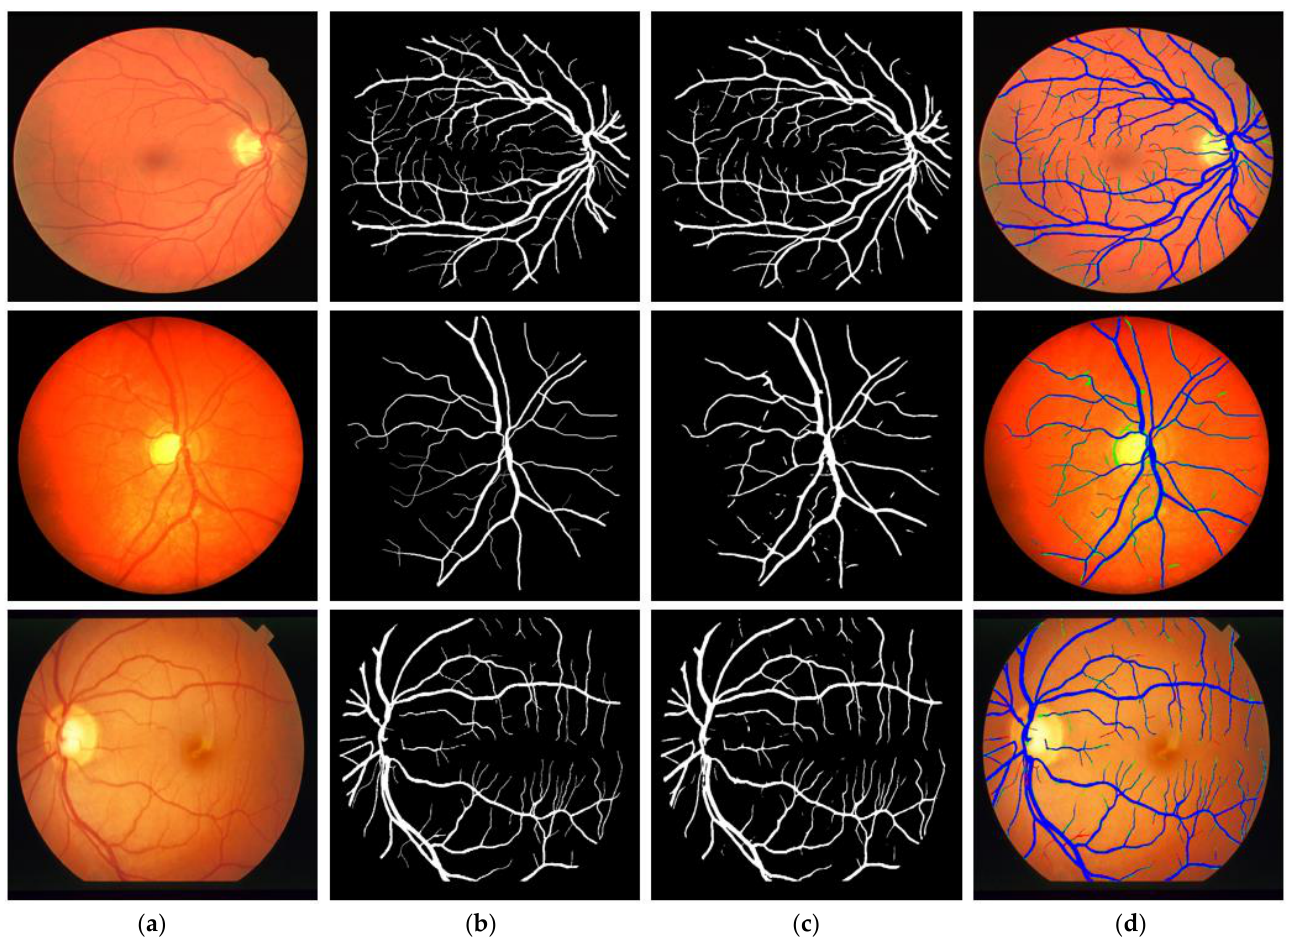
Figure 10. VSUL-Net output mask analysis for misses, discontinuities, and over-segmentation: ( a ) original fundus image, ( b ) expert annotation, ( c ) VSUL-Net predicted mask, and ( d ) mask- annotation overlapping image (TP is presented in blue, FN in red, and FP in